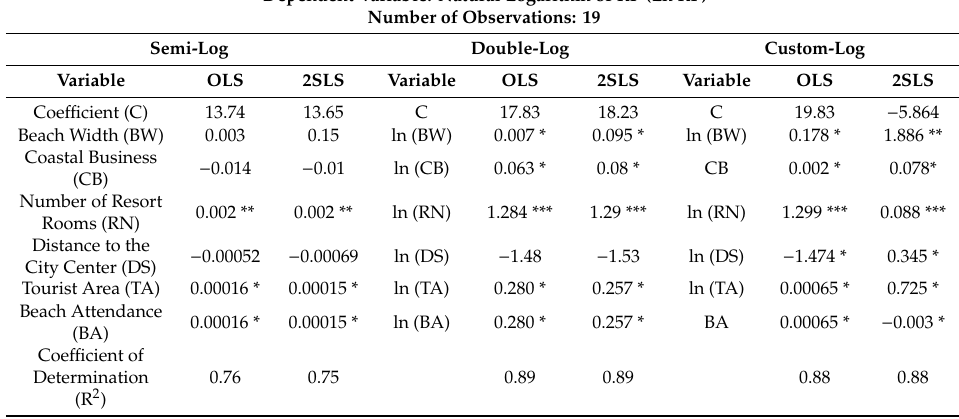
Table 2. Econometric analysis